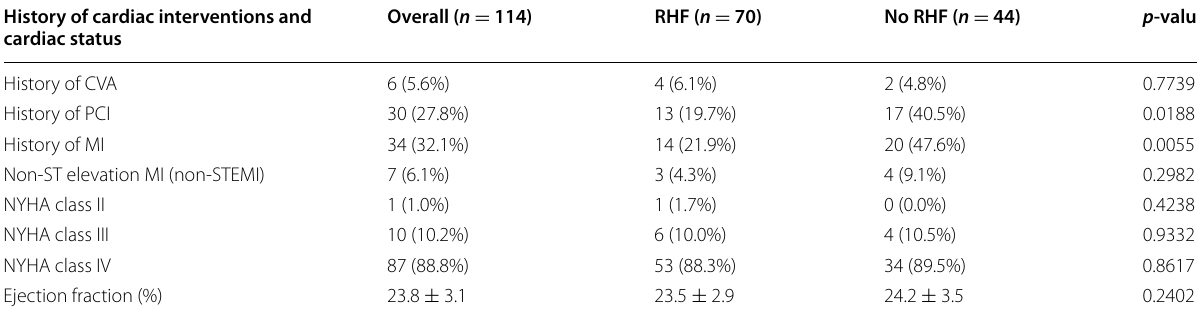
* p ‑values comparing patients with RHF vs. no RHF. **For continuous variables mean cerebrovascular accident, PCI percutaneous coronary intervention, MI myocardial infarction, NYHA New York Heart Association